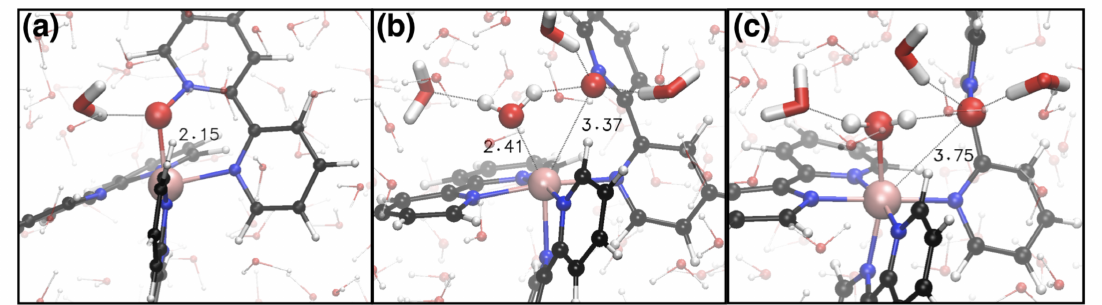
Figure 3. Representative snapshots for the catalyst activation pathway for complex A . The metal center, the NO ligand oxygen and the water molecule involved in the pathway are enlarged for clarity. The solvent molecules involved in hydrogen bonding during the process are highlighted. ( a ) The reactant state at Q = 2.15 Å, where the Ru–NO ligand moiety forms upto one hydrogen bond with the solvent, ( b ) the transition state at Q = 3.37 Å showing the approach of a solvent water molecule (H 2 O substrate ) to the metal center. Here, the ligand moiety forms upto three strong hydrogen bonds, and ( c ) The product state (Q = 3.75 Å), where the water molecule is strongly adsorbed on the metal center. The ligand NO moiety is detached from the metal center and forms several hydrogen bonds with the (solvent) water